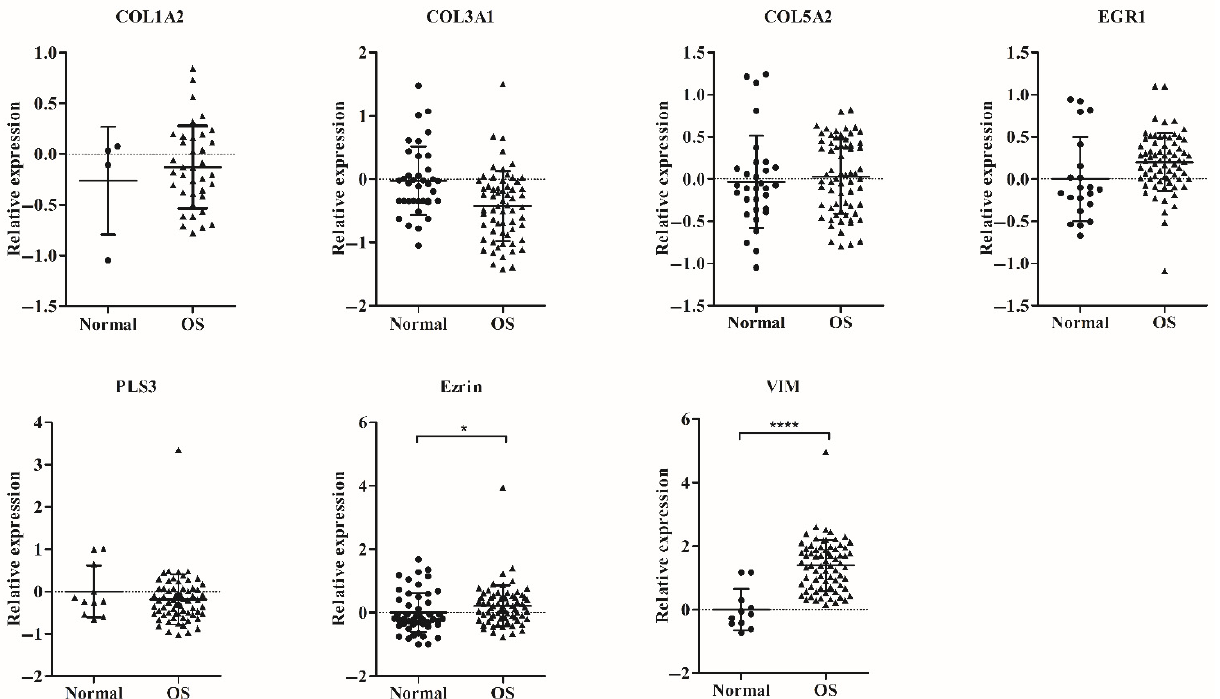
Figure 4. Detection of circulating osteosarcoma (OS) cells in the buffy coat of OS patients and healthy donors using qRT-PCR technique. Data are represented as scatter plot of COL1A2, COL3A1, COL5A2, EGR1, PLS3, ezrin , and VIM relative expression by qRT-PCR. The expressions of seven candidate genes in OS patients ( n = 73) and healthy donors ( n = 79) were quantified using qRT-PCR. Each data expression was normalized to the global mean analyzed in triplicate. Only data with Ct values below 35 are displayed as vertical scatter plot; bars represent the mean ± SD. The Mann–Whitney U-Test test was used to determine the p -values, * p < 0.05, **** p < 0.0001.